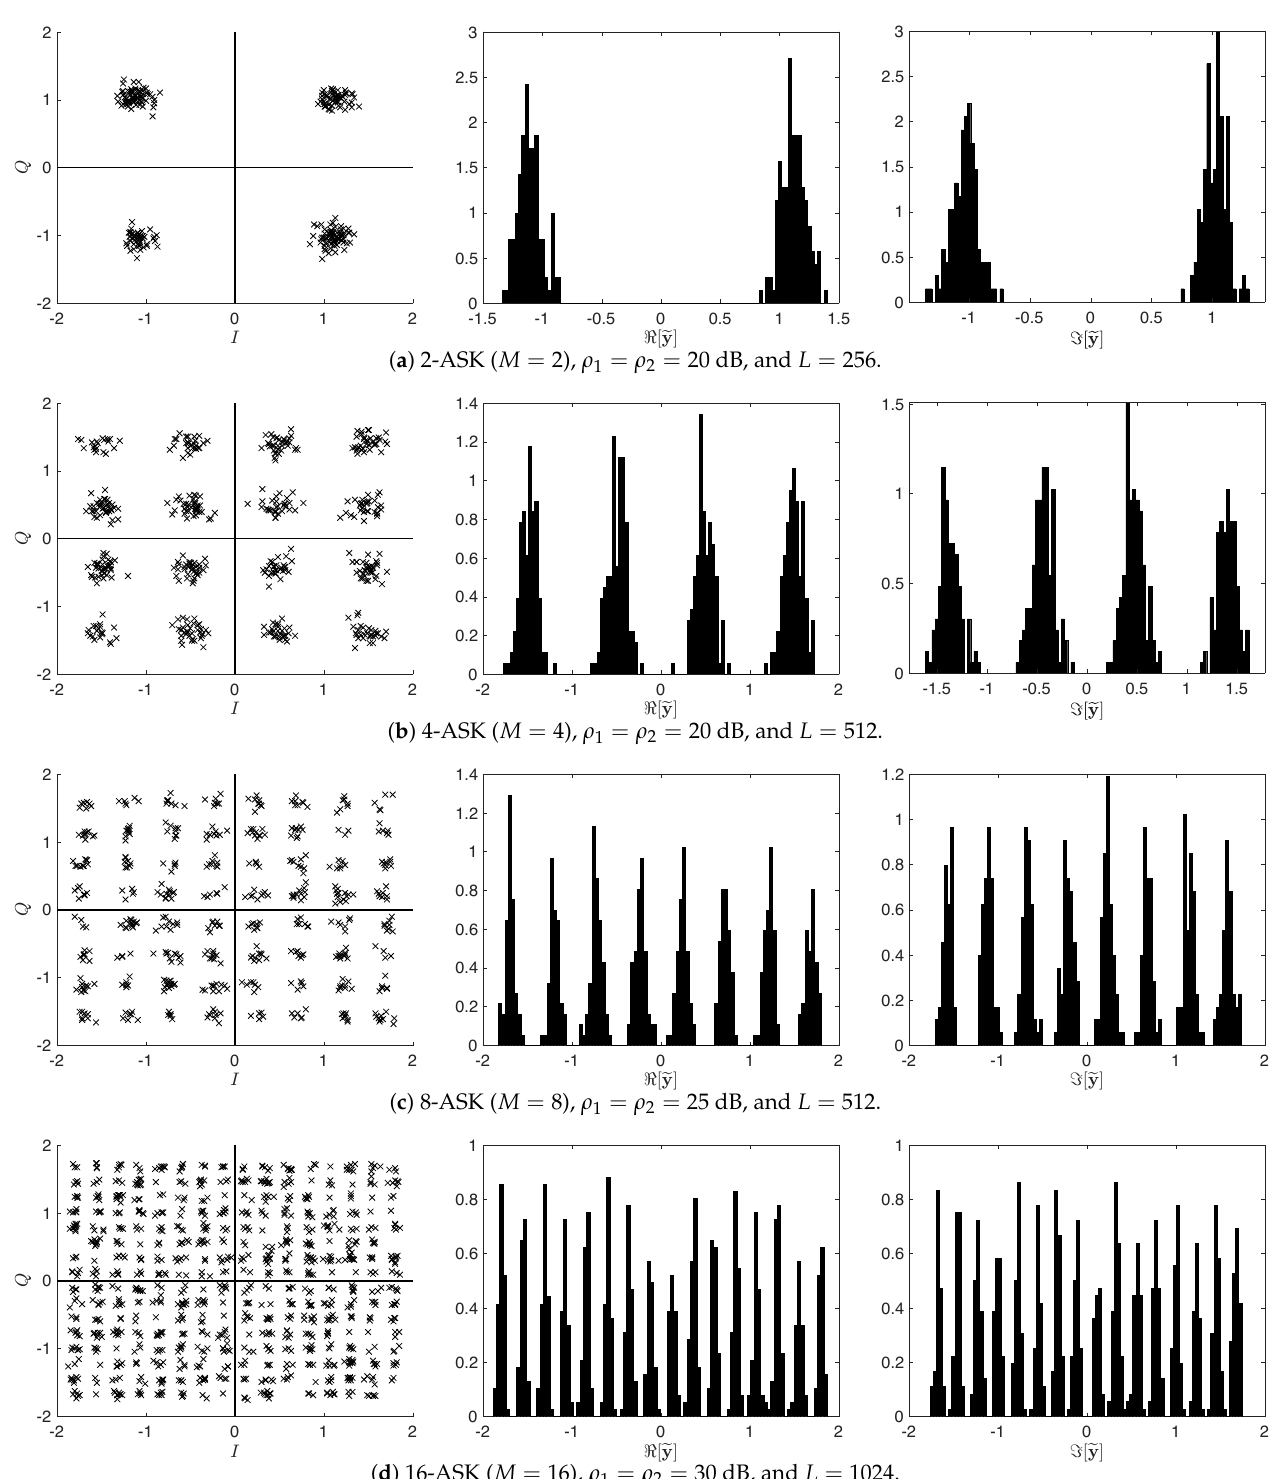
Figure 1. The constellation diagrams of (cid:101) y (first column), in-phase axis energy histograms (cid:60) [ (cid:101) y ] (second column), and quadrature axis energy histograms (cid:61) [ (cid:101) y ] (third column), for M = 2, 4, 8, 16, respectively, where P 1 = P 2 = 1, γ 1 ≈ 1.1032, and γ 2 ≈ 1.0303. For each case, the system SNR ρ n and frame length L were set appropriately to clearly present the